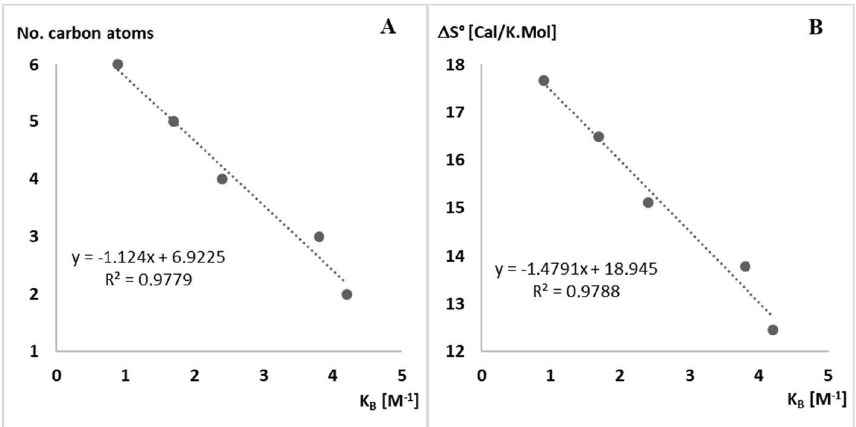
340 K. d : Gap between the standard entropy for urea models Δ S ° = S ° 340K − S ° 300K . e : Octanol–water partition coefficient as predicted by the web server molinspiration.com. f : Value of the constant the enlargement of alkyl chains led to the reduced K B value of the binding complex, and IC 50 determined against a HeLa cancer cell line. g : Value of the binding constant K B for the complex vice versa (Figure 2A) [14]. of ct DNA and ureas 11j – 11n .